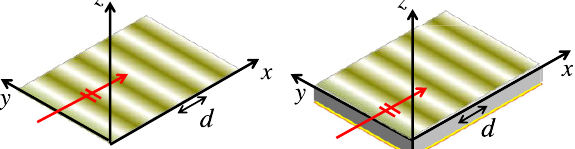
Fig. 3. Geometry for the problem of the sinusoidally modulated impedance. Left: impenetrable impedance. Right: penetrable impedance on a